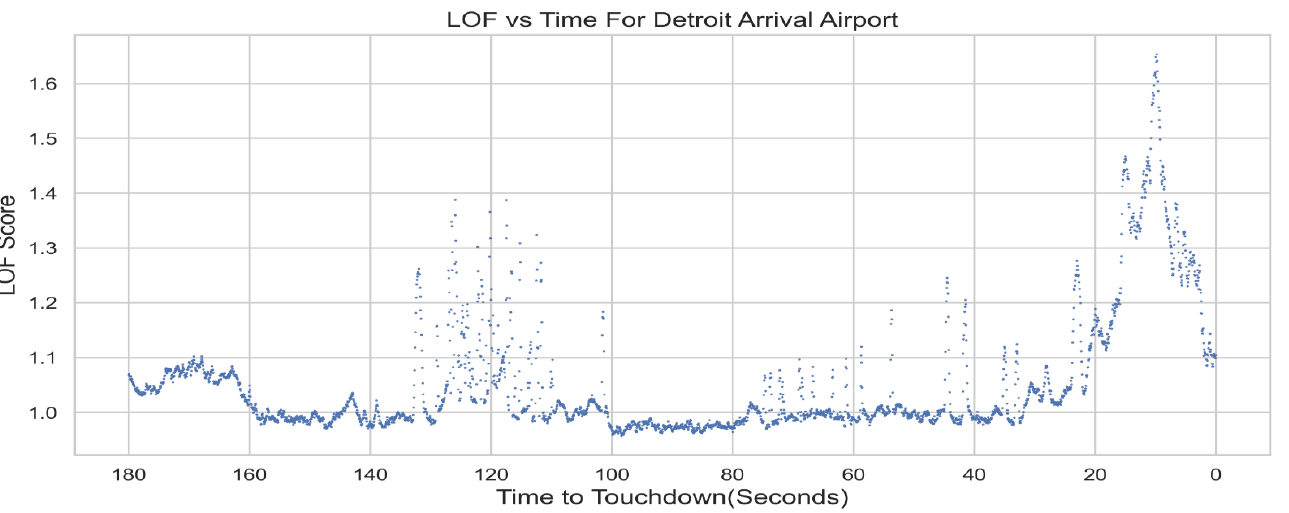
Figure 13. Changing LOF score of a flight during last 3 min before touchdown.